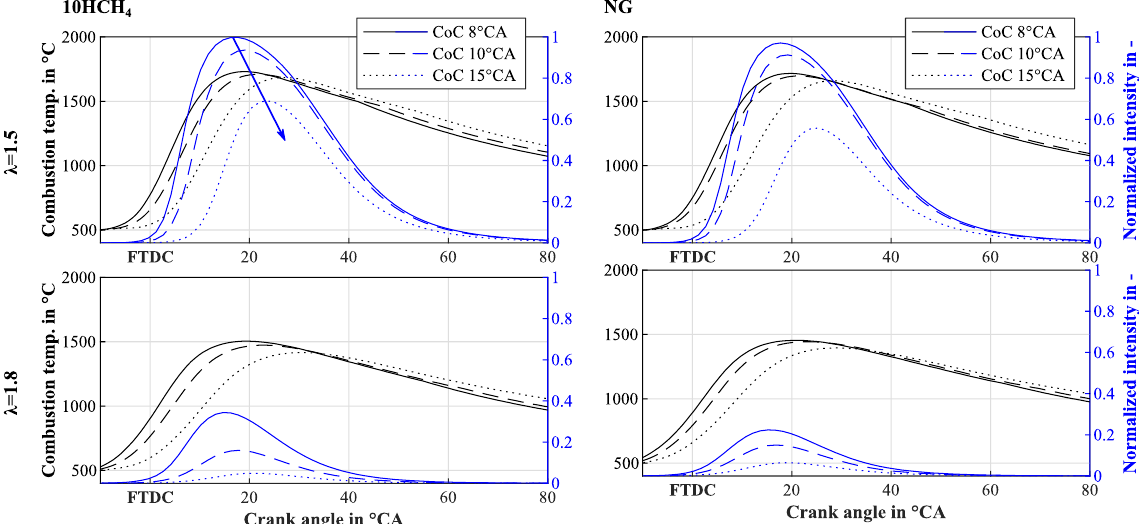
Figure 13. Normalized intensity traces and combustion temperatures for CoC variation at λ = 1.5 and 1.7 for the unscavenged pre-chamber spark plug .